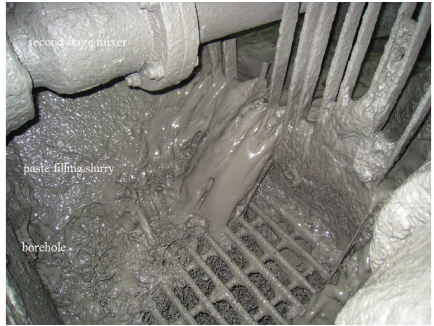
Figure 6: Paste filling slurry flowing into borehole.